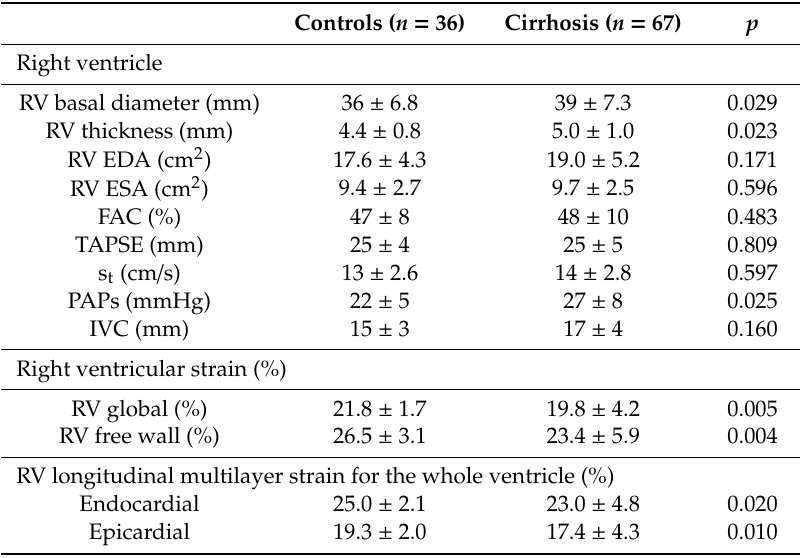
Table 2. Echocardiographic parameters of the study